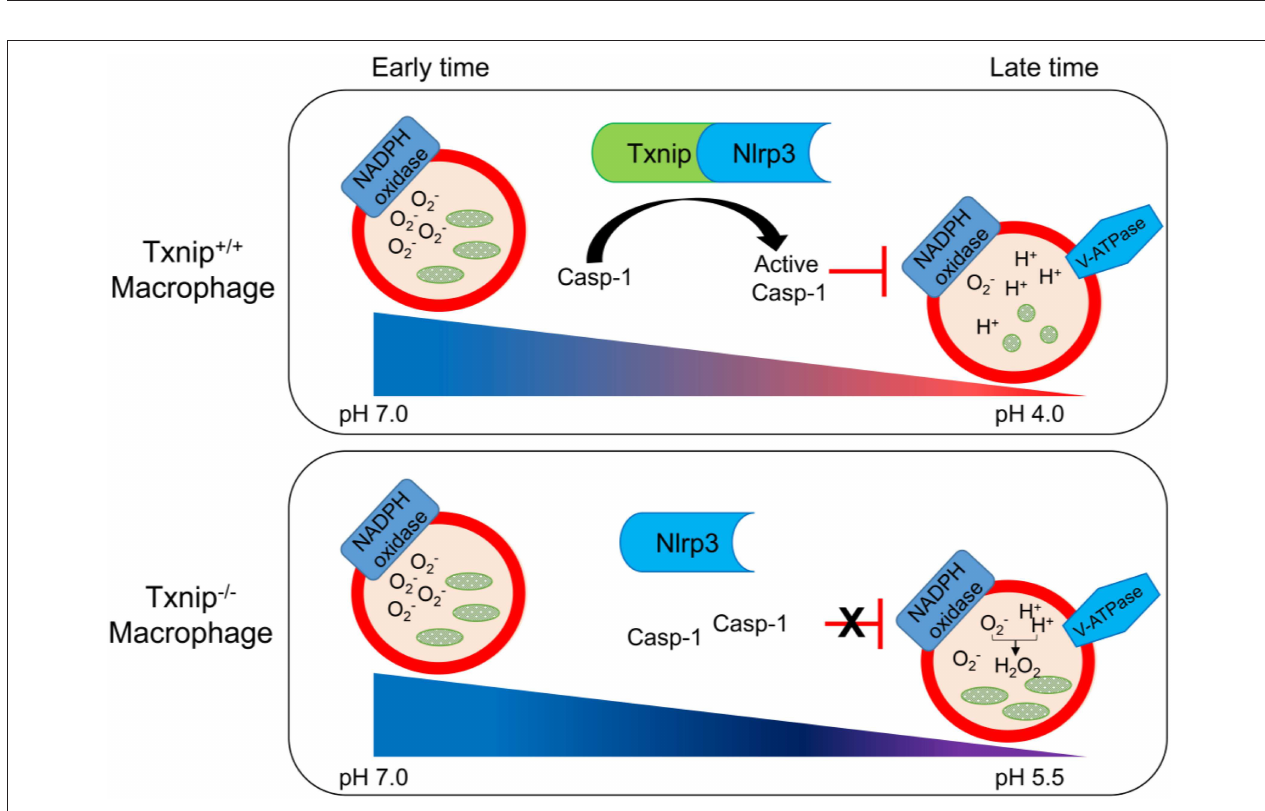
FIGURE 5 | ( n = 3, * P < 0.05, ** P < 0.01 compared with WT). (C) Representative images of spleens from WT and Txnip KO mice at the indicated times after the intraperitoneal injection of E. coli (10 8 CFU). (D) (Left) TUNEL-positive cells in liver sections from WT and Txnip KO mice 24h after the intraperitoneal injection of E. coli (10 8 CFU). (Right) The number of TUNEL-positive cells in five randomly selected fields in liver sections from WT and Txnip KO mice 24h after the intraperitoneal injection of E. coli (10 8 CFU). Data are expressed as the mean ± SD (* P < 0.05 compared with WT). (E) Survival of WT and Txnip KO mice after cecum ligation and puncture ( n = 7). (F) CFUs and representative images of LB agar plates after overnight incubation with extracts of blood, liver, and spleen from WT and Txnip KO mice obtained 24h after cecum ligation and puncture. Data are expressed as the mean ± SD ( n = 3, * P < 0.05, ** P < 0.01 compared with WT).